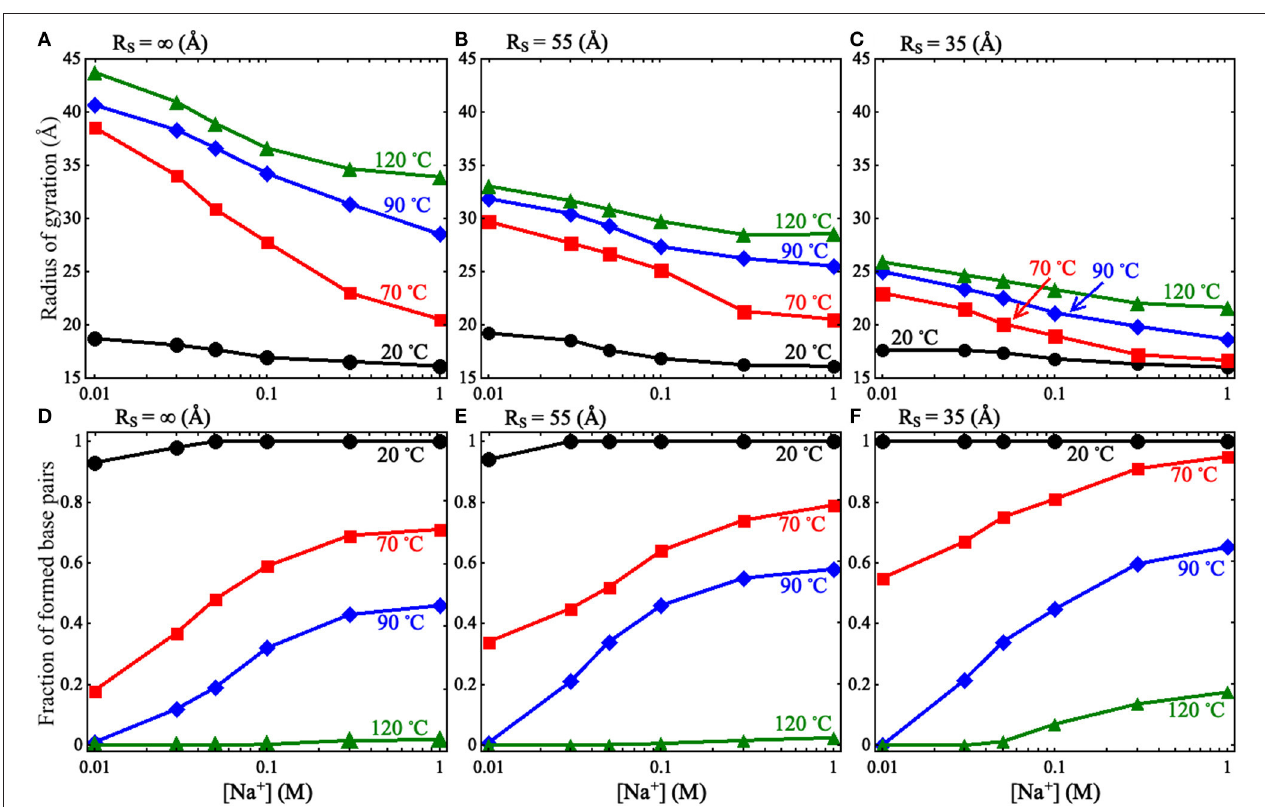
FIGURE 2 | (A–C) The radii of gyration R g as functions of [Na + ] for the mouse mammary tumor virus (MMTV) pseudoknot at different temperatures and spatial confinements: (A)